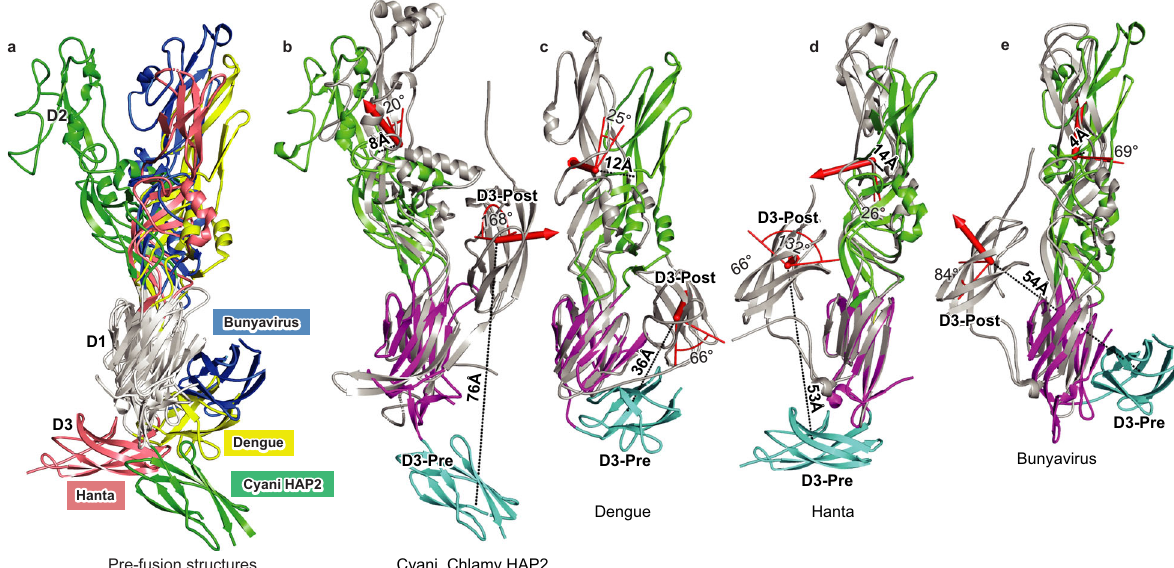
Fig. 4 D2 and D3 domain reorientation between pre- and postfusion states of HAP2 and viral fusogens. a – e Structures were superimposed on D1 using DeepAlign 23 . a Superimposition of prefusion structures on D1 (colored white) with D2 and D3 colored as shown in key. b – e D2 and D3 movements in the postfusion state are shown as distance of center of mass (Å) and as rotation (°) with axis at new center of mass. b HAP2 prefusion (PDB 7S0K) and postfusion (PDB 6DBS, chain C). c Dengue (PDB 1OKE, and 1OK8). d Hantavirus (PDB 5LJZ and 5LJY). e Bunyavirus (PDB 4HJ1 and 5J81). Chain A was used unless stated otherwise. The same analysis is shown for D2.1 relative to D1 and D2.1 relative to D2.1 in Supplementary Figure 1A. Using DeepAlign, intact pre and postfusion monomers were aligned with D1 to monomeric Cyani HAP2. Individual D2 and D3 domains were then aligned (1) with prefusion monomers and next (2) with the postfusion monomers to calculate the transformation using the orientation.py script from